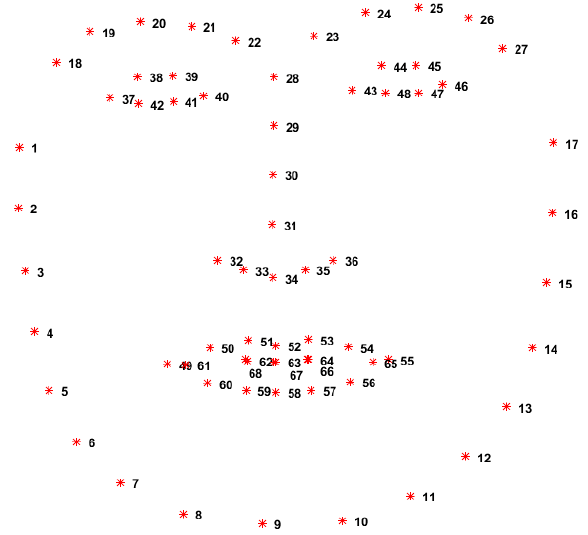
Figure 3. Schematic representation of the 68 facial landmarks identified by the algorithm implemented in the OpenFace